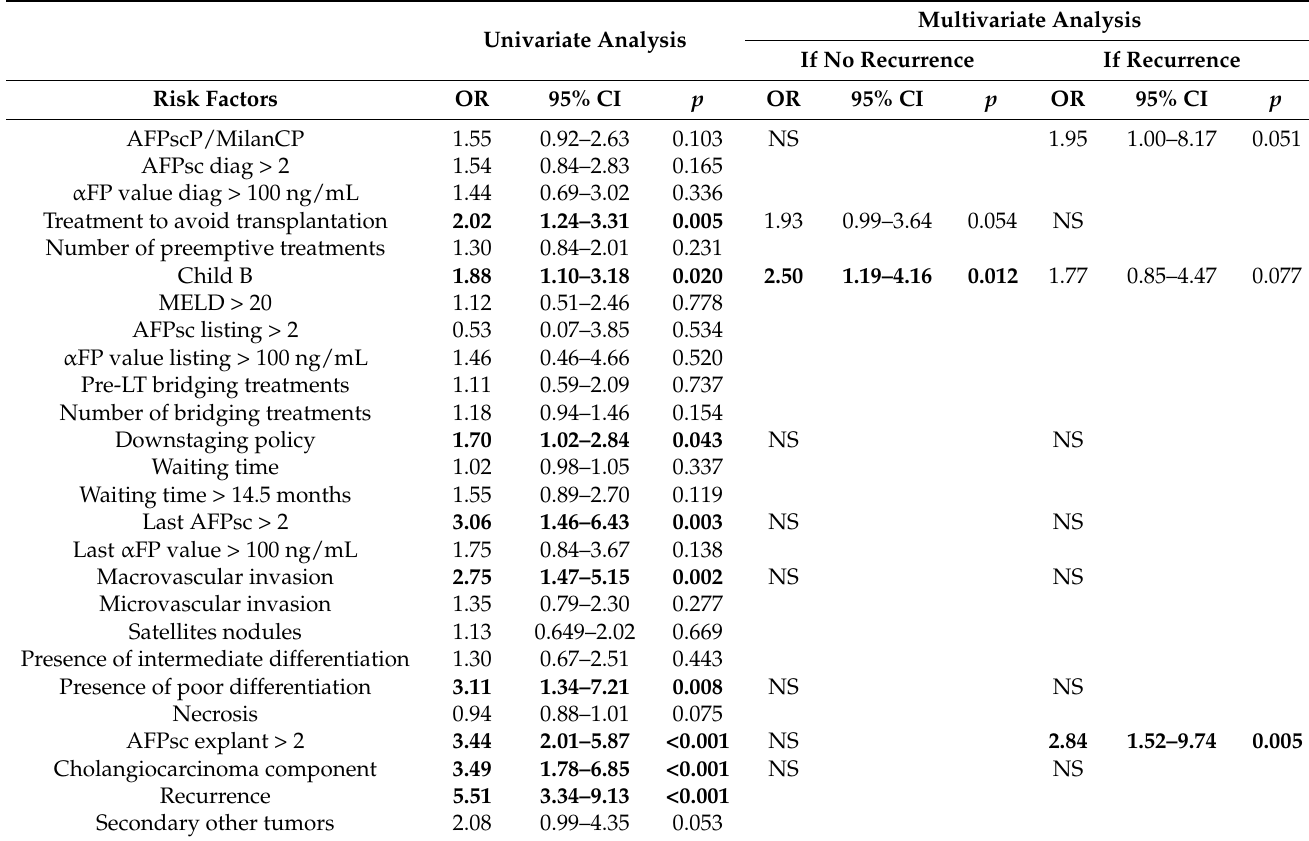
Table 6. Risk factors for post-transplantation death: univariate and multivariate analysis (n = 364). Multivariate Analysis Univariate Analysis If No